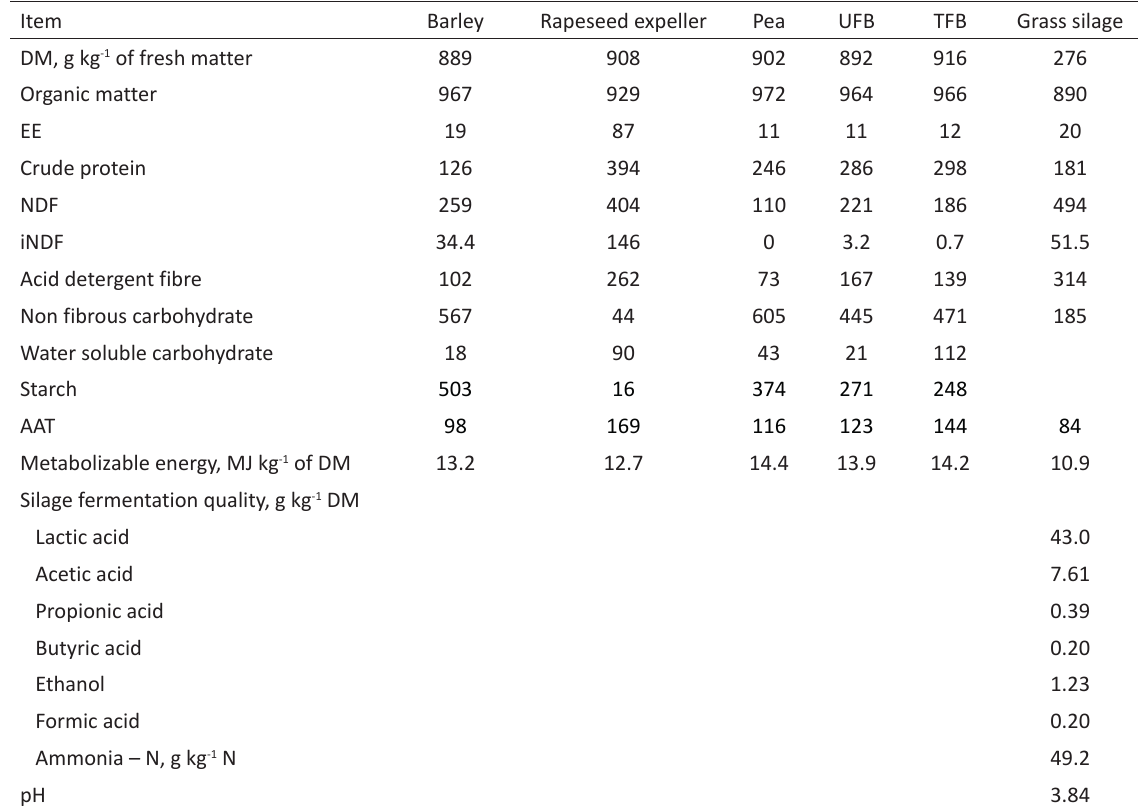
Table 2. Chemical composition, g kg -1 of dry matter (DM) unless otherwise noted of ingredients Item